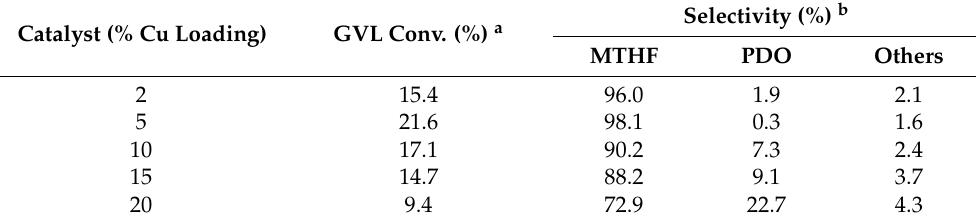
Table 5. Hydrogenation of GVL to 2-MTHF over various Cu/SiO 2 catalysts with various Cu loadings. Catalyst (% Cu Loading)